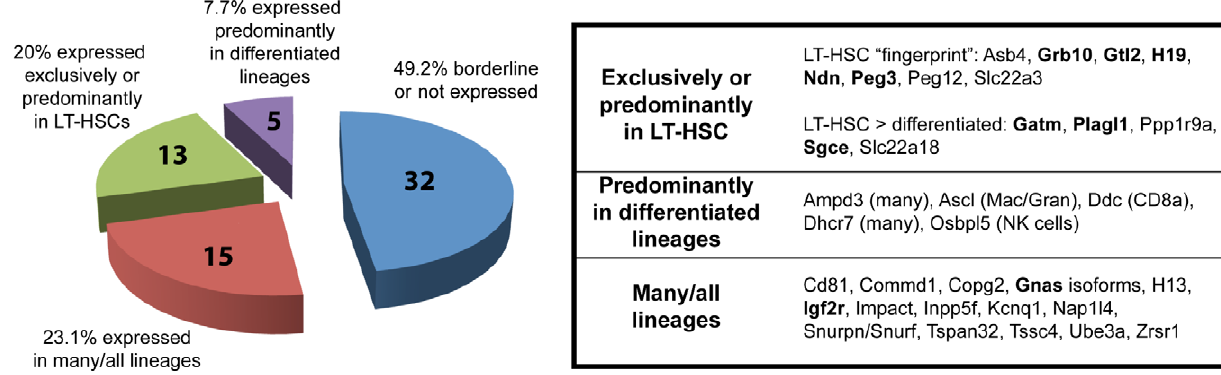
Figure 1. Summary of microarray analysis of imprinted gene expression in hematopoiesis. Microarray data from mouse LT-HSCs and differentiated lineages [11] were analyzed for the expression of known imprinted genes. The chart (left) shows the distribution of genes according to the specificity of their lineage distribution; the individual genes in each expression category are listed to the right (genes previously identified as being part of the IGN, as defined by Varrault et al. [16] are noted in bold-face type). Supplementary information is provided in Table S1, showing the description of the core IGN genes in this study.